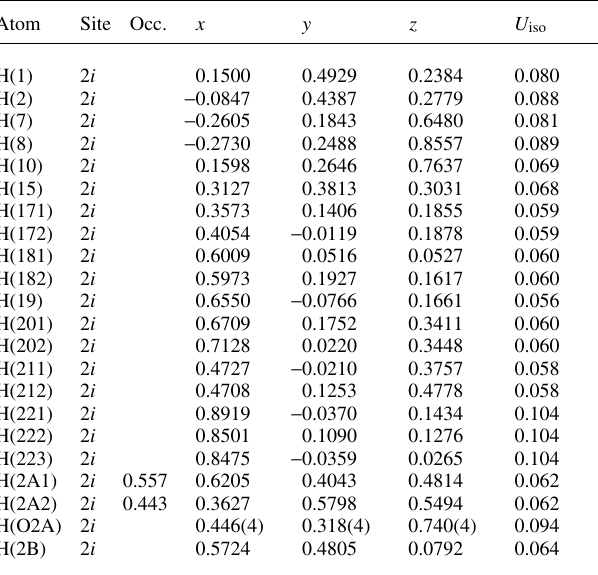
Table 2. Atomic coordinates and displacement parameters (in Å 2 ) .